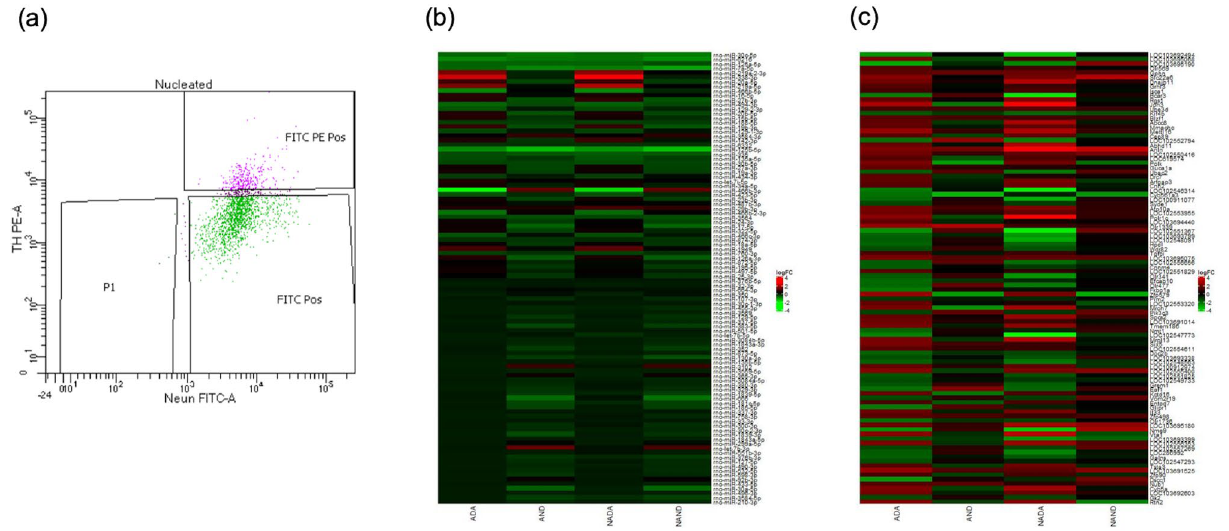
Figure 1. FACS and heat maps following microarray analysis. ( a ) FACS analysis results for DA and non-DA VTA neuron sorting. Heat maps from microarray analysis showing the top 100 ( b ) DEmiRs and ( c ) DEGs for both DA and non-DA VTA neurons following perinatal exposure to alcohol or combined nicotine and alcohol. Expression profiles are based on greatest absolute log fold